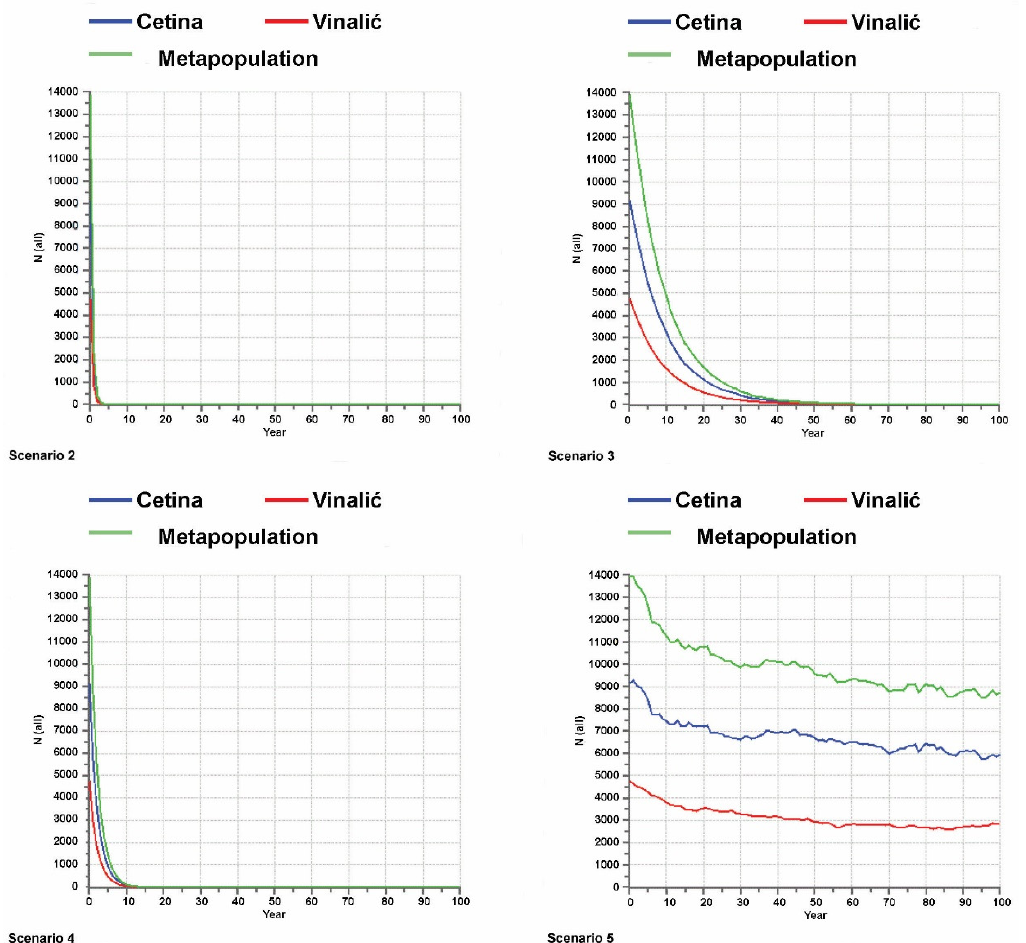
Figure 4. Results of population viability analyses for T. ukliva based on six scenarios.